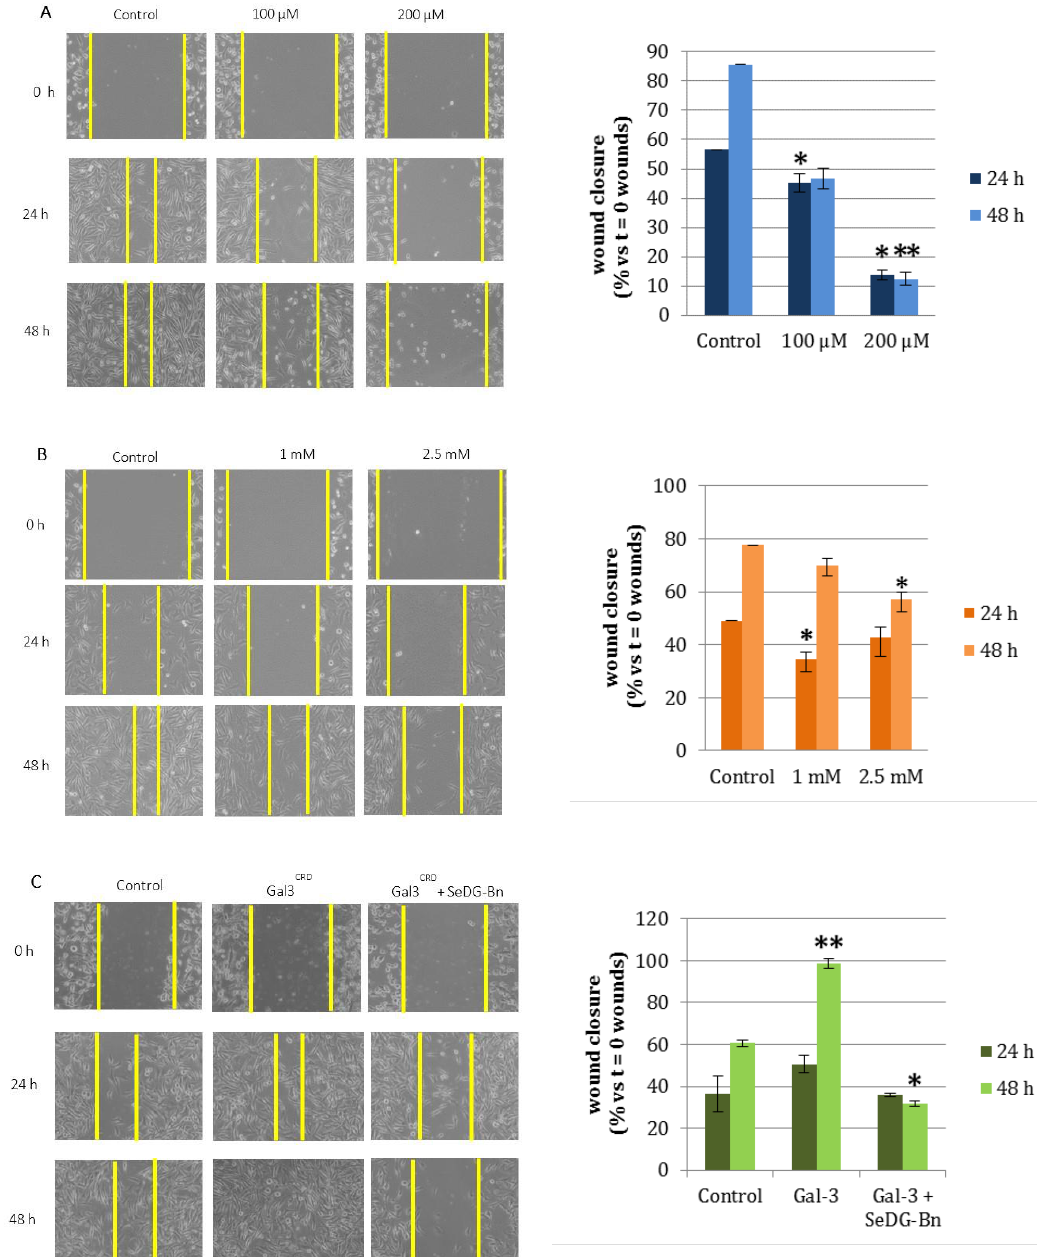
Figure 5. Cell wound healing assay. Effect of compounds on wound healing activity. WM266 cells were scratched and treated with ( A ) SeDG-Bn and ( B ) SeDG at the indicated concentrations. ( C ) WM266 cell after scratch in the presence of 50 µM Gal-3 CRD or 50 µM Gal-3 CRD pre-incubated with 200 µM SeDG-Bn. Each scratch area on the monolayer was photographed at 0, 24, and 48 h. The distance between the limits of the scratch was quantified and the size of wound closure was determined as follows: % wound closure = 1 − (wound width tx/wound width t0) × 100. Bars depict mean ± SE of three independent experiments, ** p < 0.01 * p < 0.05.